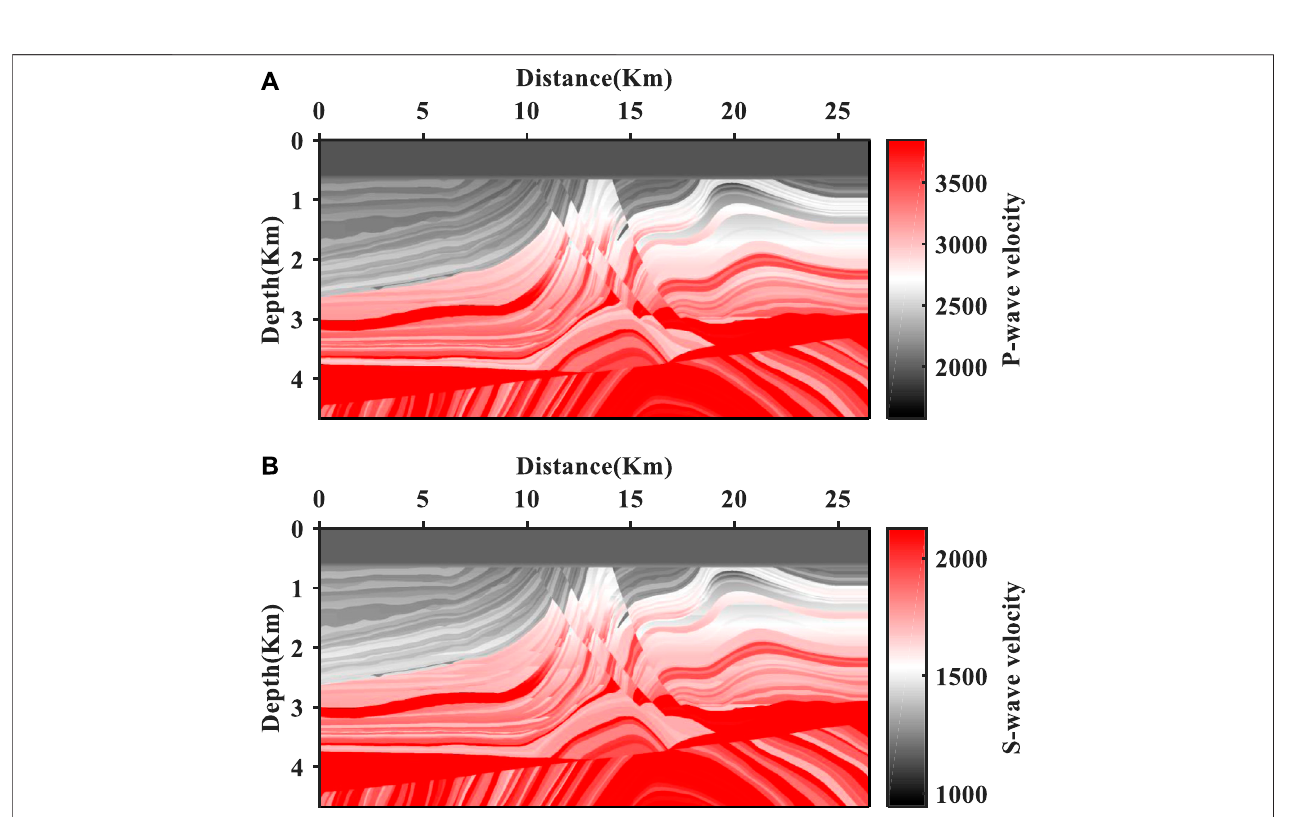
FIGURE 14 | The P-wave velocity of the elastic Marmousi 2 model (A) and the S-wave velocity of the elastic Marmousi 2 model (B) and the density is constant of 1 g/cm 3 .